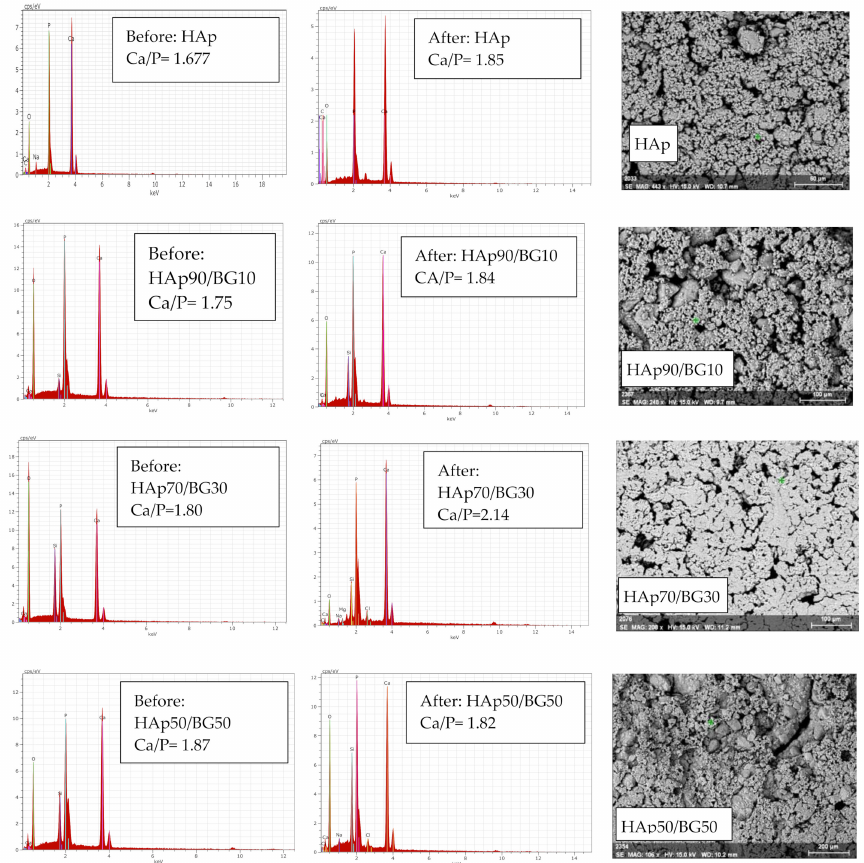
Figure 9. SEM images after immersion and EDX results for samples before and after 14 days of immersion in SBF